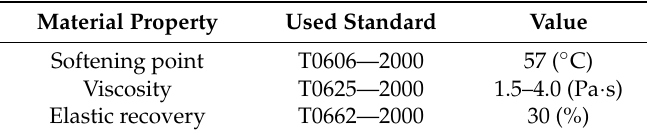
Table 1. Properties of asphalt rubber.